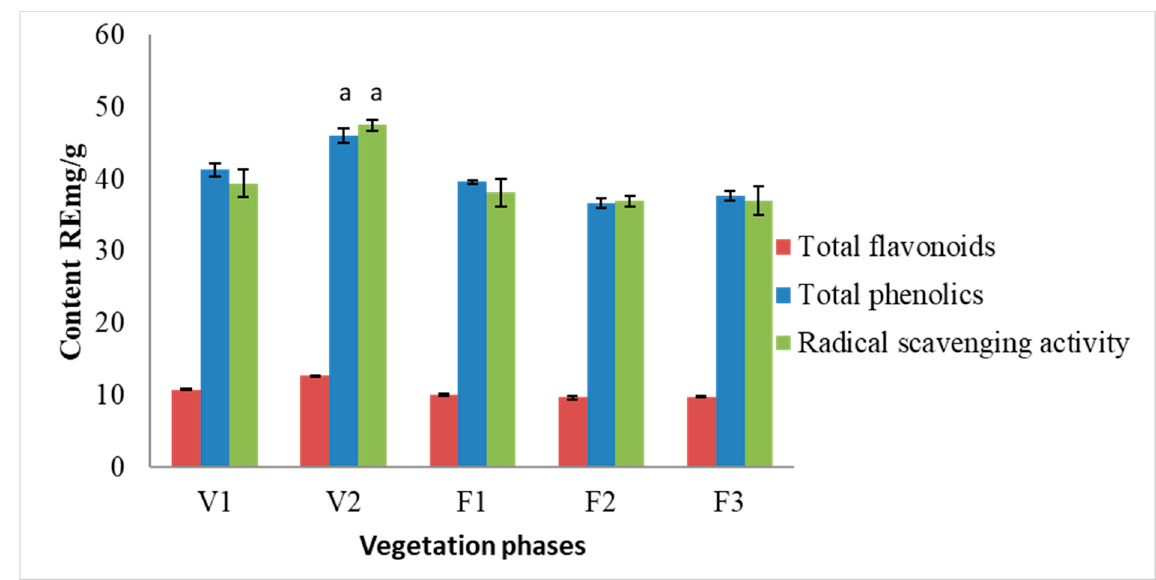
Figure 2. Variation of total flavonoid and phenolic compounds and radical scavenging activity of methanolic extracts of S. hortensis L. from different vegetation phases, determined using spectrophotometric methods. Mean values ± SD from three independent experiments are presented. a statistically significant differences vs. V1 phase, p < 0.05.